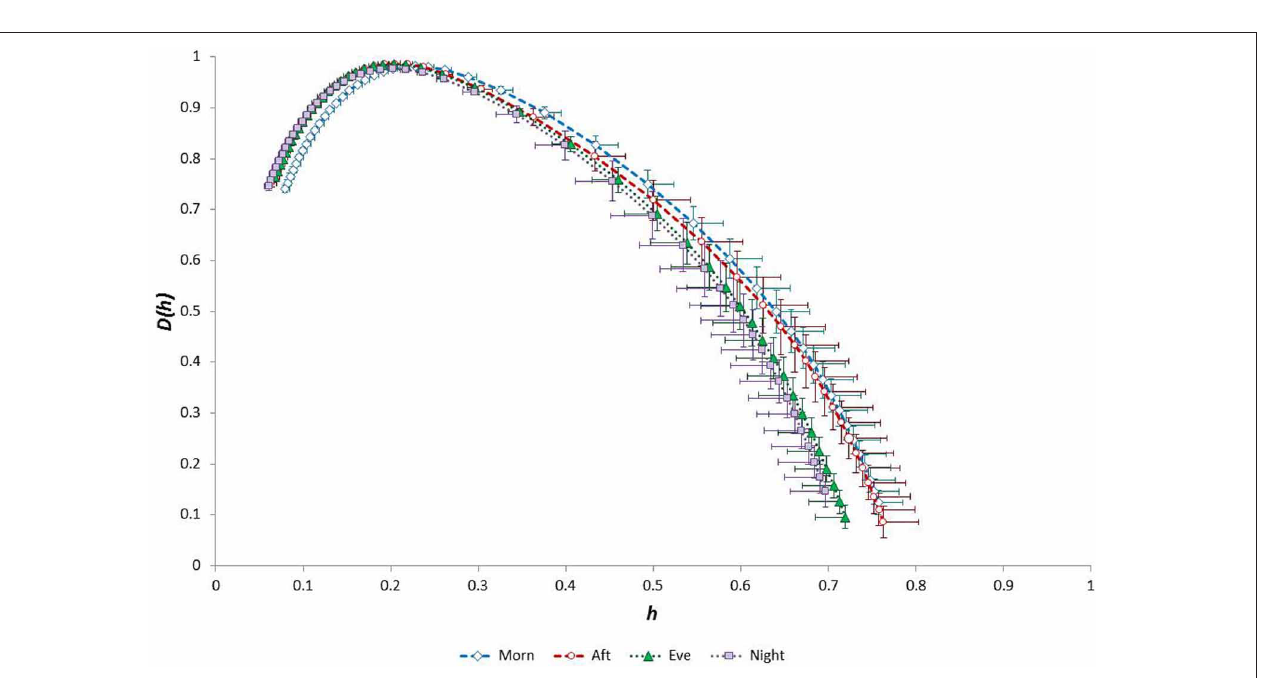
FIGURE 11 | Singularity multifractal spectra by “time of day” calculated for surrogate data (amplitude adjusted Fourier transformation of original